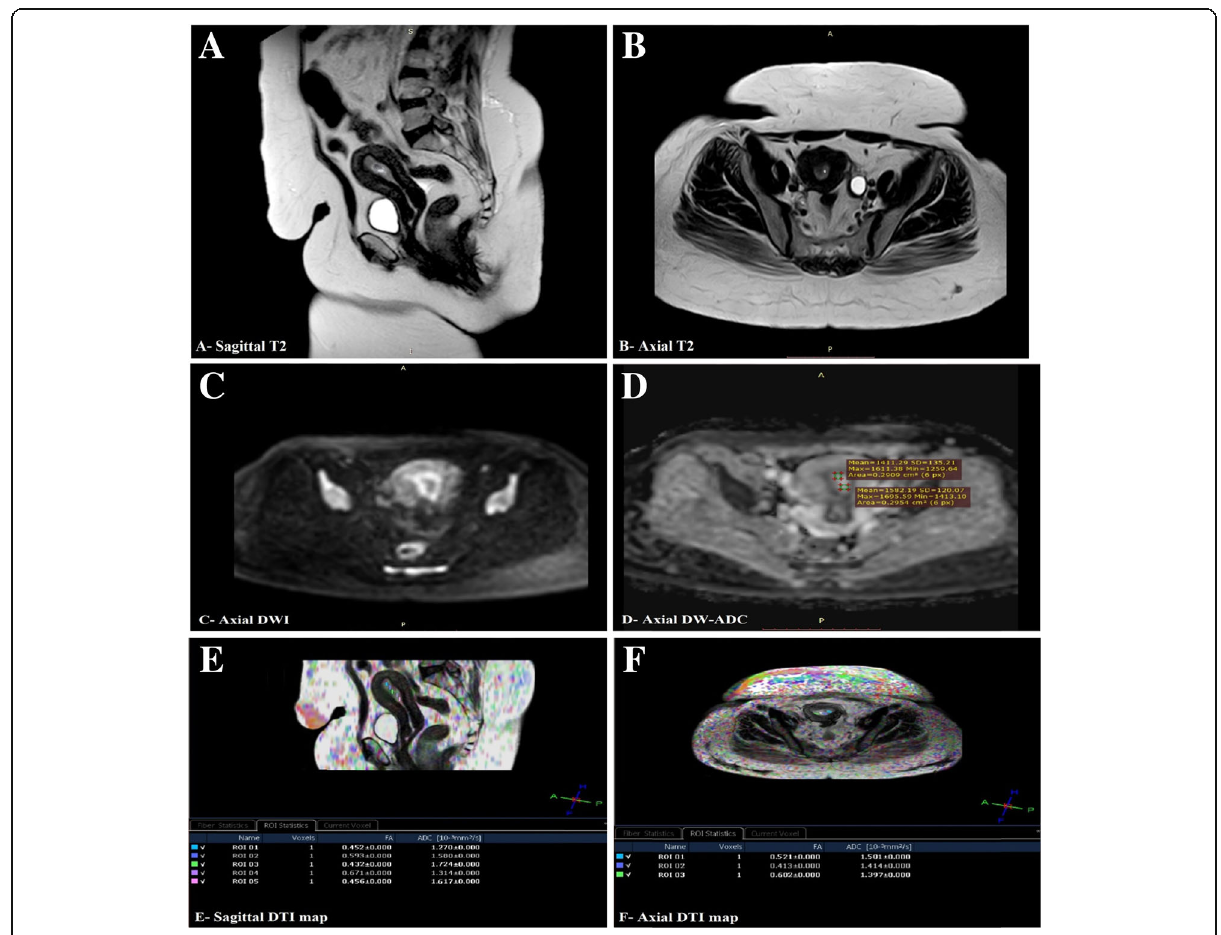
Fig. 3 A 54-year-old postmenopausal female presented by abnormal vaginal bleeding. On TVS examination, there was a large echogenic lesion in the endometrial cavity measuring about 12mm in diameter with cystic changes inside. a, b Sagittal and axial T2 WIs show endometrial thickening. The polyp appears of slightly low signal intensity compared with normal endometrium (red lines). There is a low signal intensity central fibrous core (blue arrows), and small high signal intensity intratumoral cyst (yellow arrows). c Axial DWI with b value of 1000s/mm 2 shows high signal intensity of the thickened endometrium. The polyp appears of intermediate SI lower than that of the endometrium (red arrow). d Axial DW-ADC map image shows thickened endometrium with intermediate signal intensity. Mean DW-ADC value = 1.511 × 10 − 3 mm 2 /s. e , f Sagittal, and axial DTI map images demonstrate endometrial polyp mean